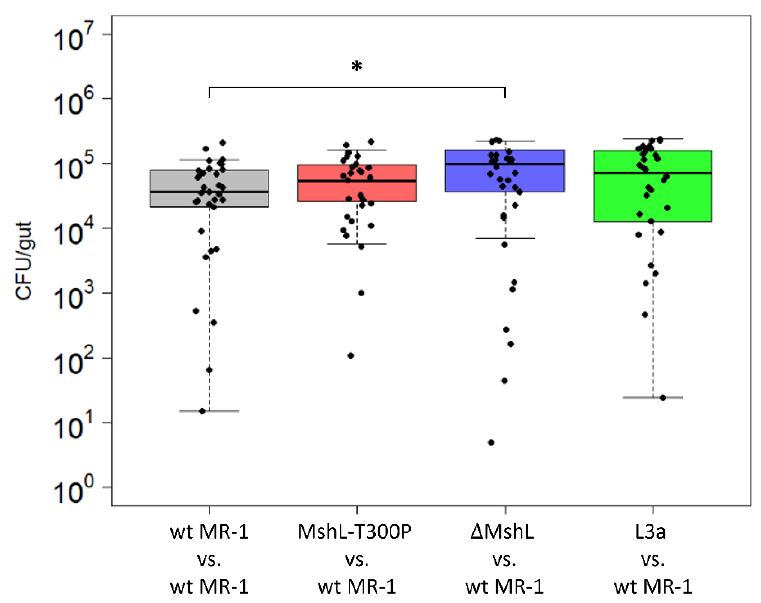
Figure 2. Colonization density achieved in larval guts after 72 h of colonization under competitive conditions. Dissected guts were plated on tryptic soy agar (TSA) and CFUs (colony forming units) were counted. Each point represents a single dissected gut (n = 30 larvae per comparison). Only the ∆ MshL versus wt MR-1 results are different than the control group based on a two-tailed t -test with Bonferroni multiple comparison correction ( p < 0.05: *). Three batches of larvae were used to generate these data, and batch was evaluated as a random effect.